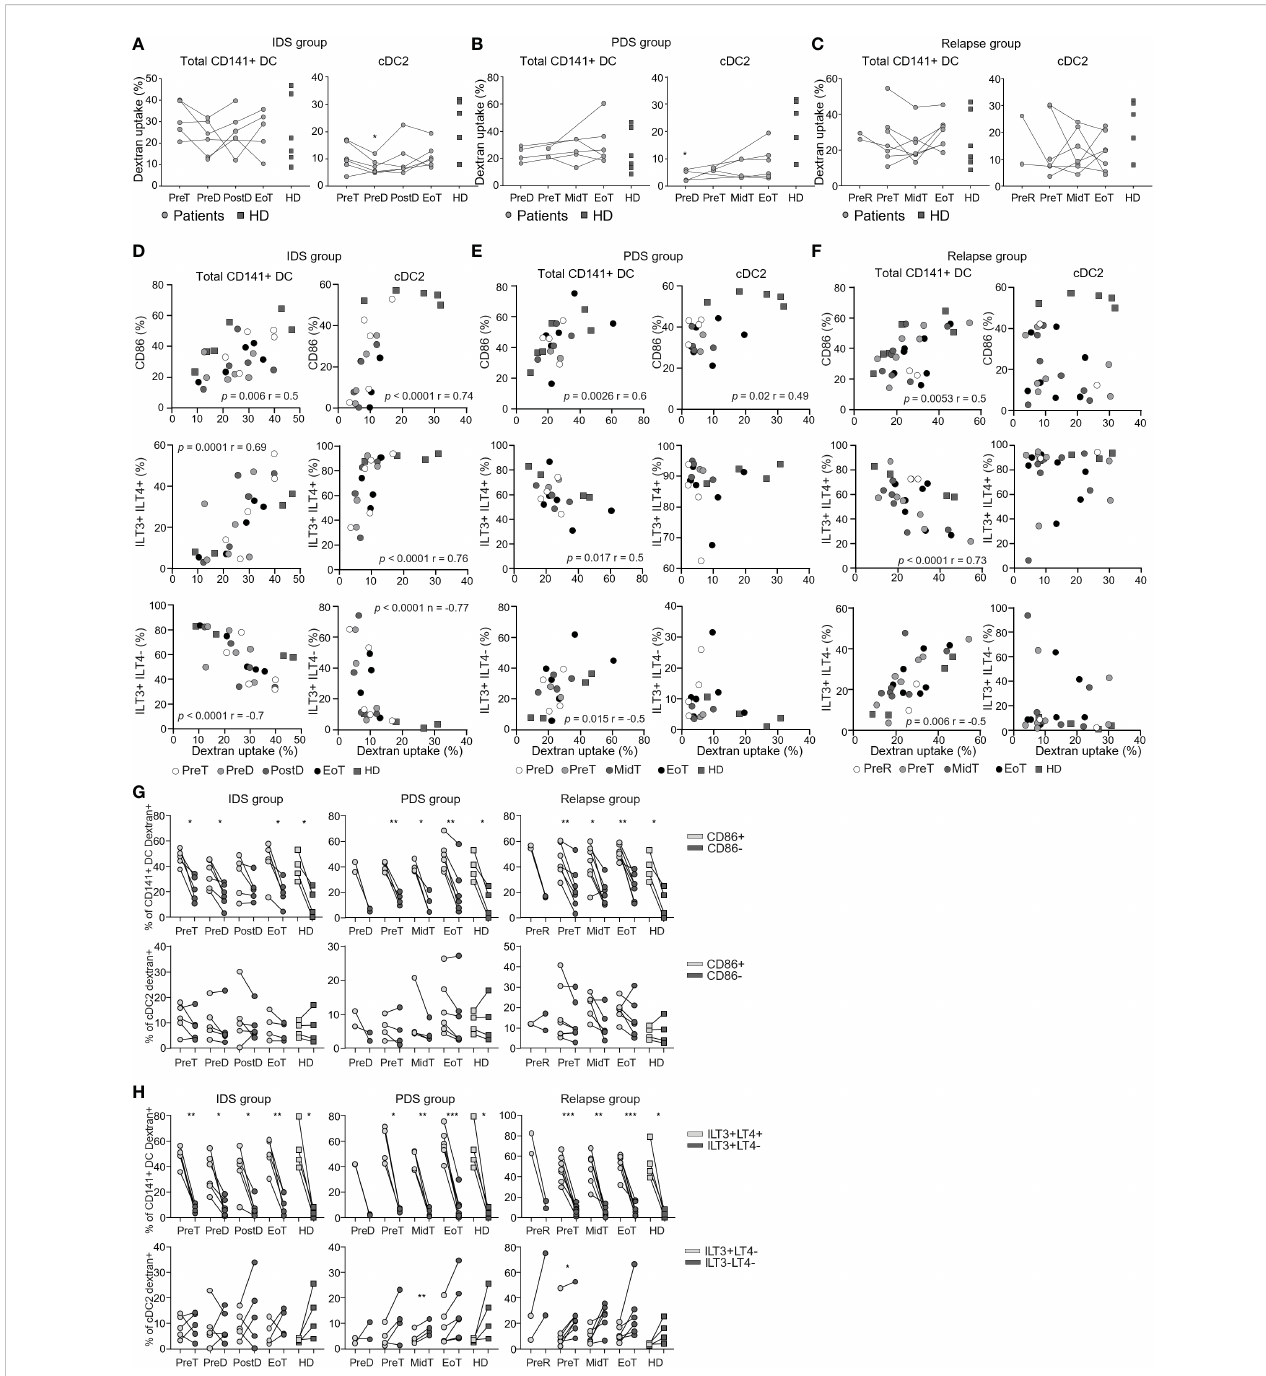
FIGURE 3 Longitudinal monitoring of the capacity to uptake dextran in vitro by DC populations in patients with OvC and in HD. Cumulative data of the frequency of dextran positive total CD141 + DC and cDC2. Measurements were performed in patients with OvC (grey dots) at recruitment, during treatment and at EoT, and compared to HD (dark grey squares). We show data from patients undergoing (A) IDS treatment regimen, (B) PDS treatment regimen and (C) relapsing patients. * p < 0.05, ** p < 0.01. One-way ANOVA tests followed by pairwise Dunn ’ s tests. Correlations between the frequency of dextran positive total CD141 + DC and cDC2 and the frequency of total CD141 + DC positive for CD86, ILT3 and/or ILT4 or the frequency of cDC2 positive for CD86, ILT3 only or negative for both ILT3 and ILT4. Correlations were performed with data derived from HD and patients undergoing (D) IDS treatment regimen, (E) PDS treatment regimen and (F) relapse. Spearman ’ s rank correlation tests were performed. (G) Cumulative data of the frequency of dextran positive total CD141 + DC/CD86 + (light grey symbols) or CD141 + DC/CD86 - (dark grey symbols) and cDC2/CD86 + (light grey symbols) or cDC2/CD86 - (dark grey symbols) measured in HD and in patients with OvC belonging to the IDS, PDS or relapse group. (H) Cumulative data of the frequency of dextran positive total CD141 + DC/ILT3 + ILT4 + (light grey symbols) or CD141 + DC/ILT3 + ILT4 - (dark grey symbols) and cDC2/ILT3 + ILT4 - (light grey symbols) or cDC2/ILT3 - ILT4 - (dark grey symbols) measured in HD and in patients with OvC belonging to the IDS or PDS or relapse group. * p < 0.05, ** p < 0.01. One-way ANOVA tests followed by pairwise Dunn ’ s tests. ***p <